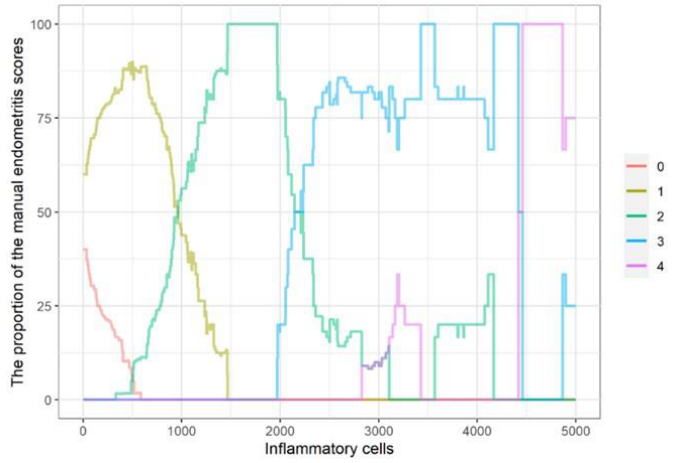
Figure 8. The proportion of examiner1 ’ s manual endometritis scores according to the total cases in the interval of inflammatory cell number ± 300. As the inflammatory cell count increases, the manual endometritis scores also increase, but there is considerable overlap between the different severity categories.